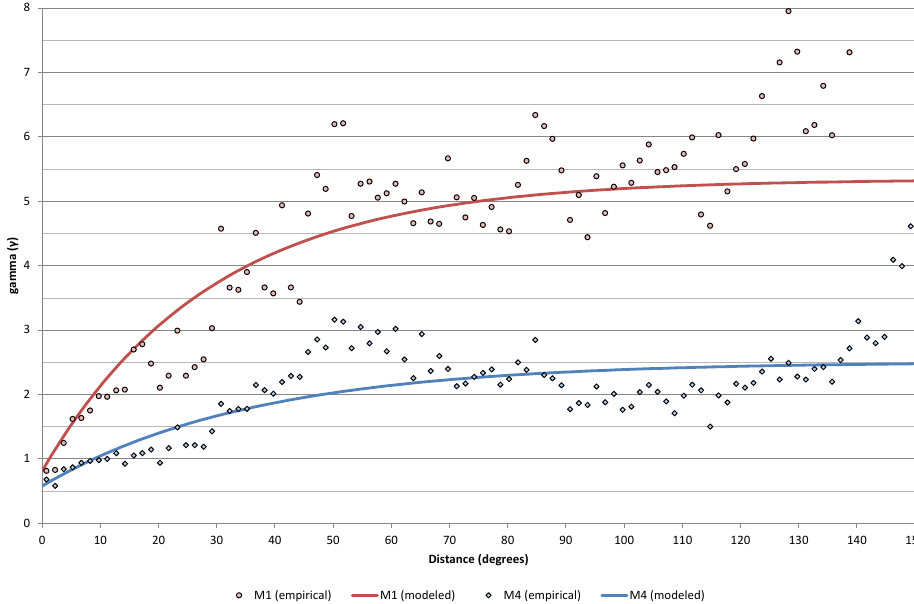
Fig. 9. Empirical (symbols) and the modeled (lines) variograms for δ 18 O ANN of models M1 and M4. Increased predictive precision (e.g., lower gamma values) over larger distances ( x axis) means better performance.